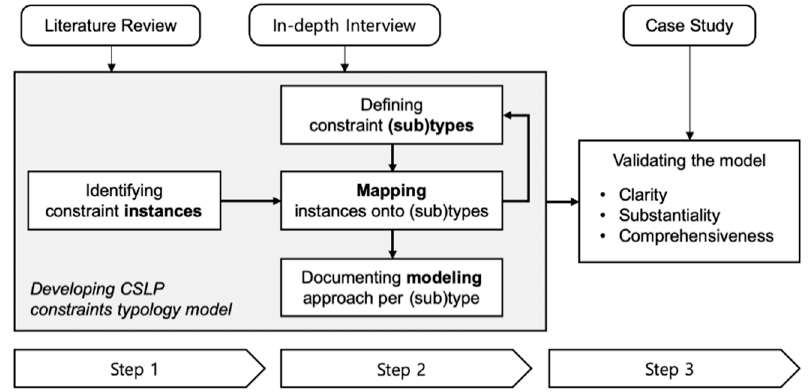
Figure 2. Overview of research methods.